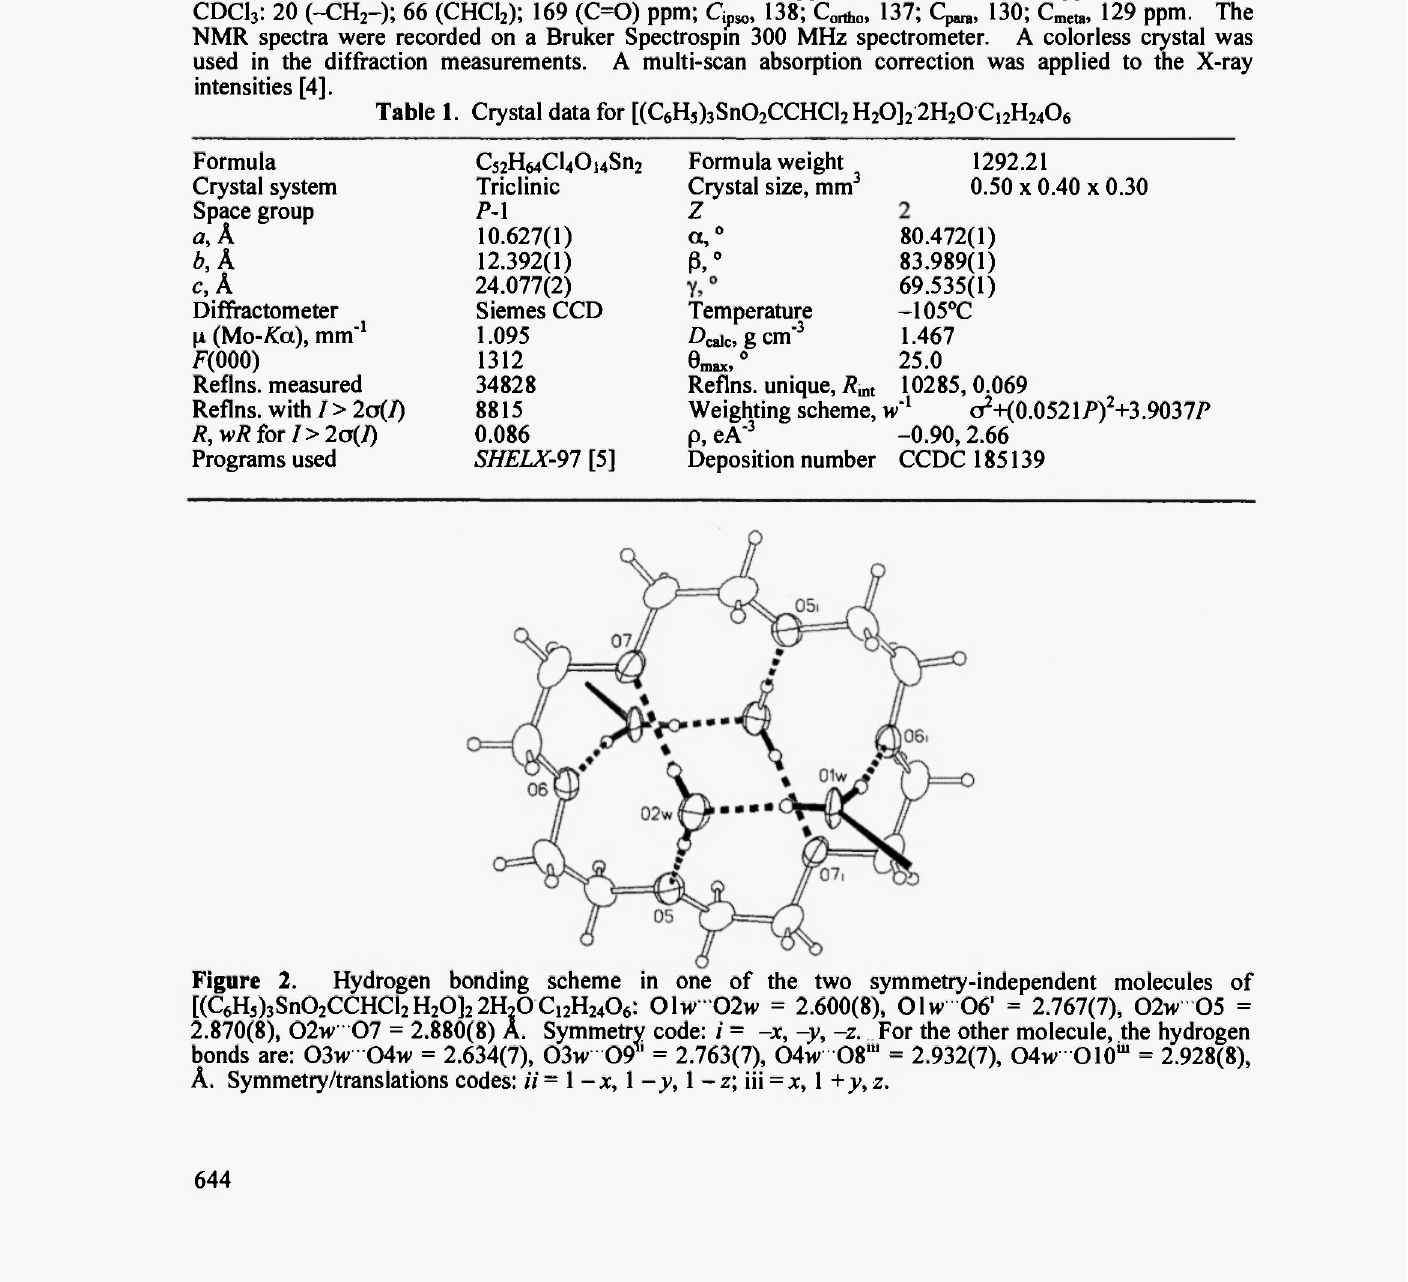
Hydrogen bonding scheme in one of the two symmetry-independent molecules of